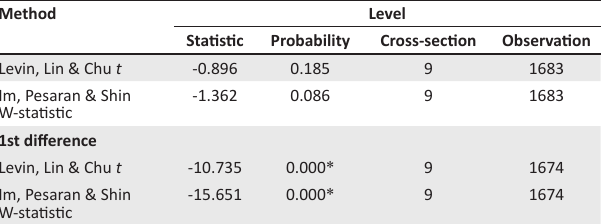
TABLE 5: Panel unit root test: Terms of trade. Method